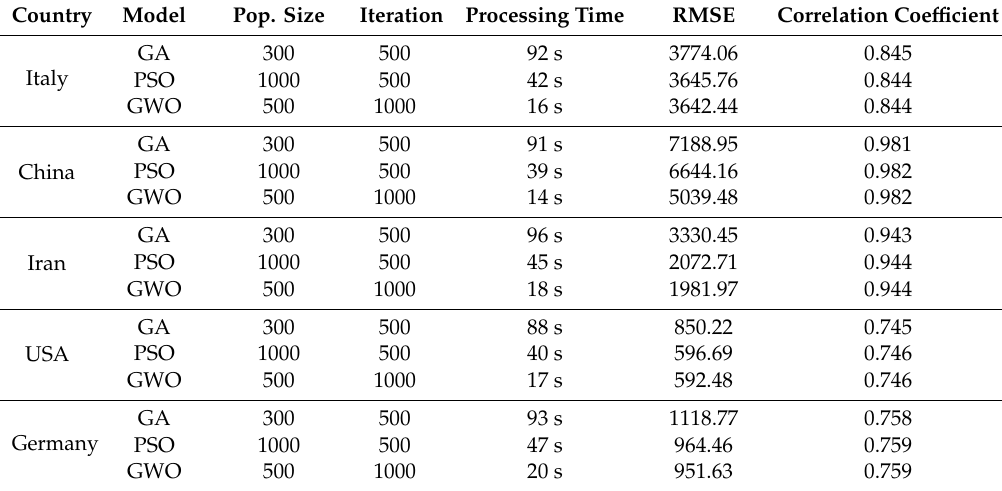
Table 4. Accuracy statistics for the linear model.